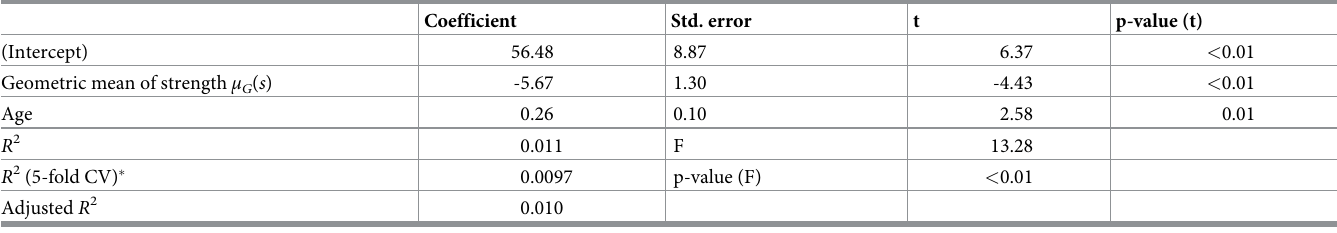
Table 5. Regression analysis of duration of hospital stay D in by geometric mean of strength μ G ( s ) and age at admission. Coefficient